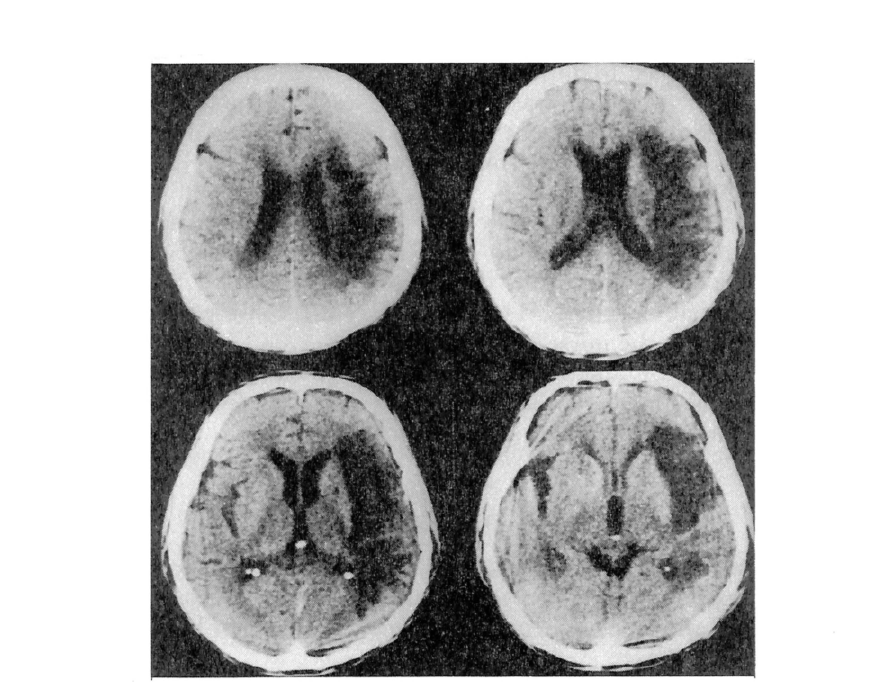
FIG. 3. Computed tomography of the brain of case 3. Infarction includes extended area of the territory of the right middle cerebral artery sparing the territory of the lenticulostriate